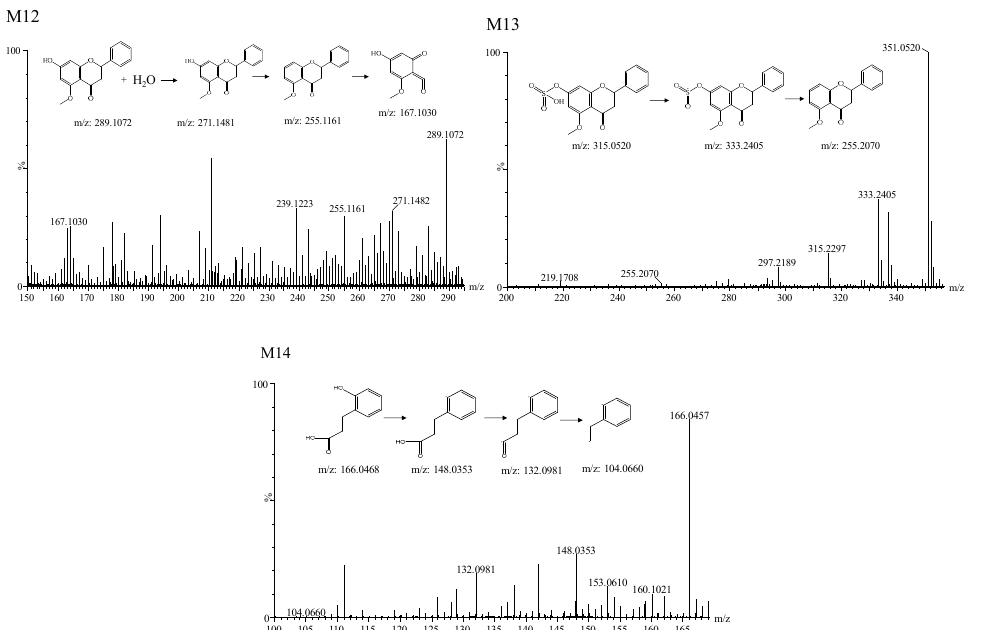
Figure 3. Structure and the MS 2 spectrum of the alpinein and its probable metabolites.